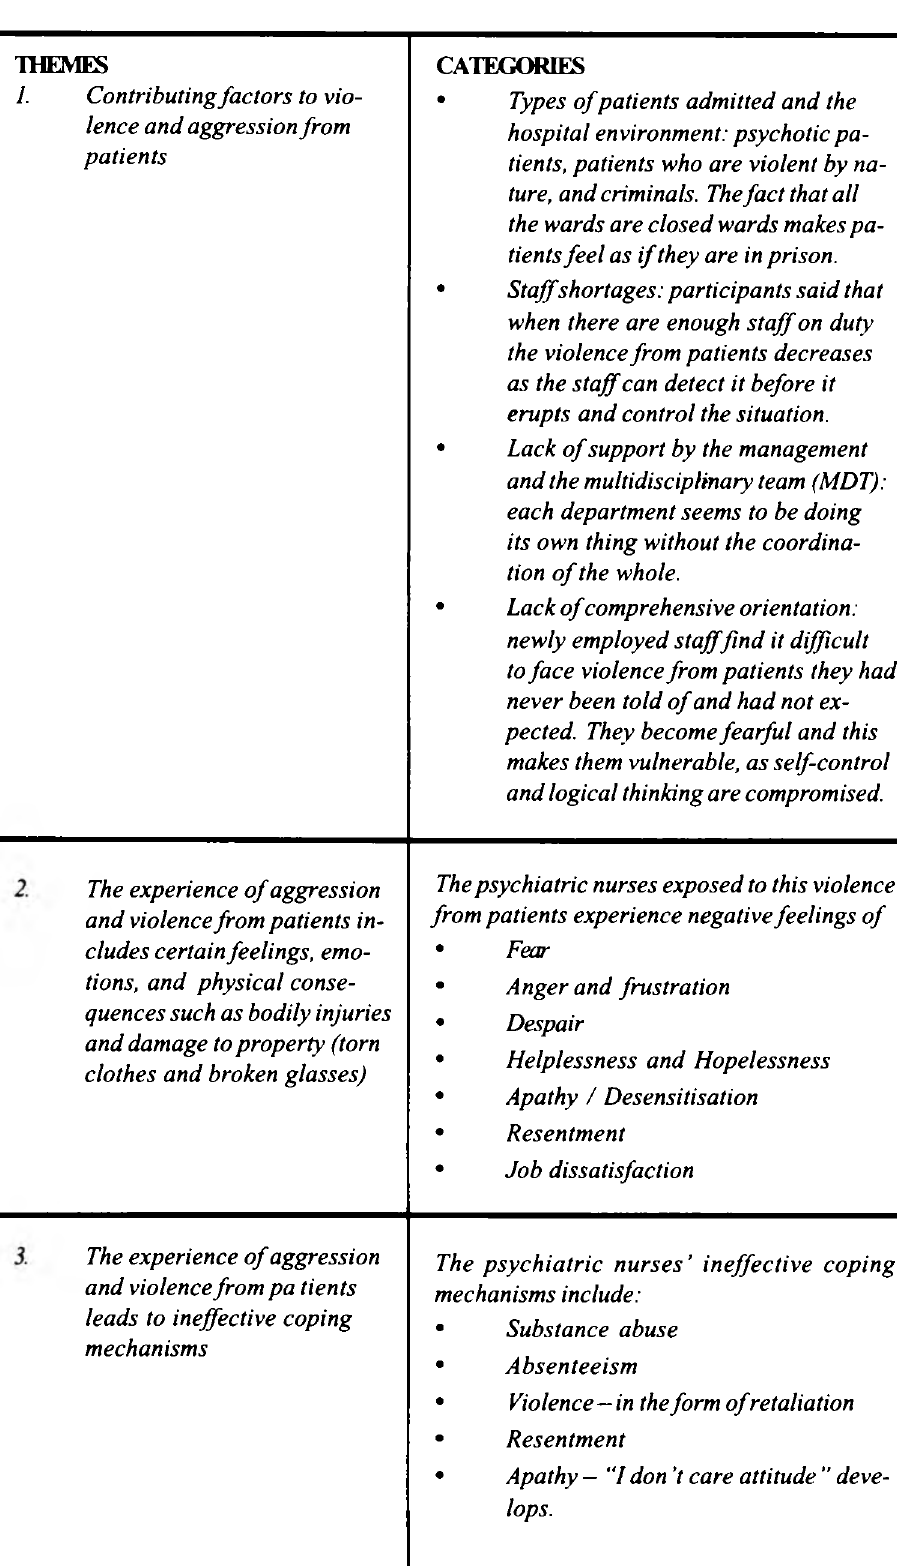
Table 1 Summary of the themes and categories identified during data analysis